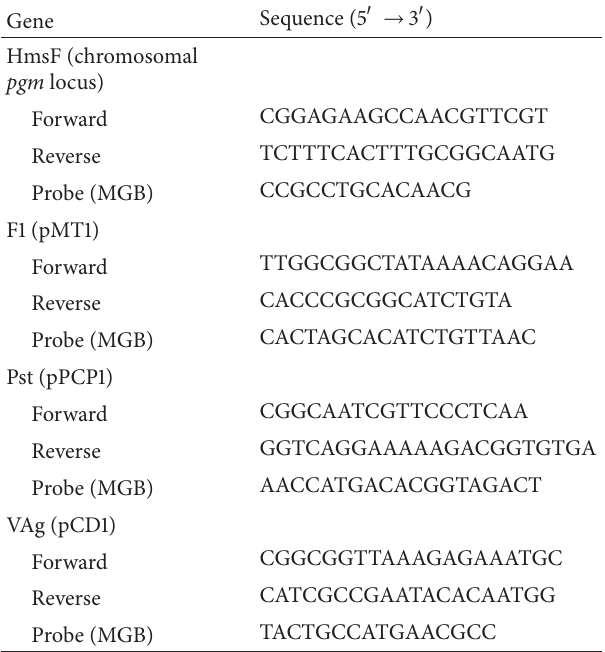
Table 1: Genetic primer targets of the PCR test used to ensure integrity of the inoculum. All primer probe design was based on GenBank accession number NC 003143 ( Yersinia pestis CO92, complete genome). MGB is minor groove binder/nonfluorescent quencher covalently bound to the 3 󸀠 end of the probe. All probes have a 5 󸀠 fluorescein (FAM)